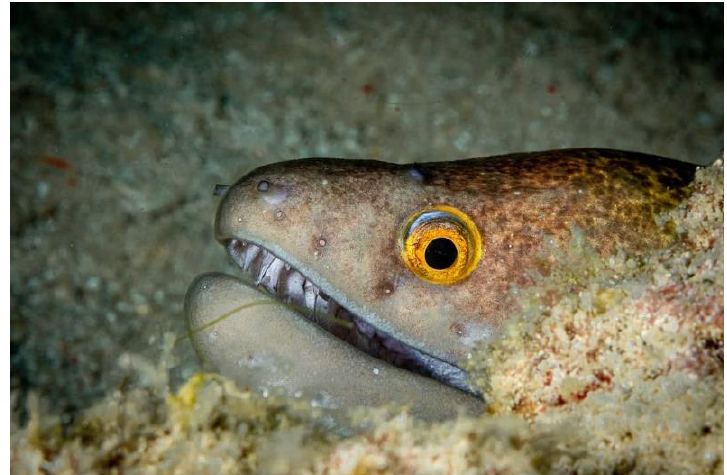
Figure 2. Moray eel. Permission for photo was taken from Yalçın Aydın.